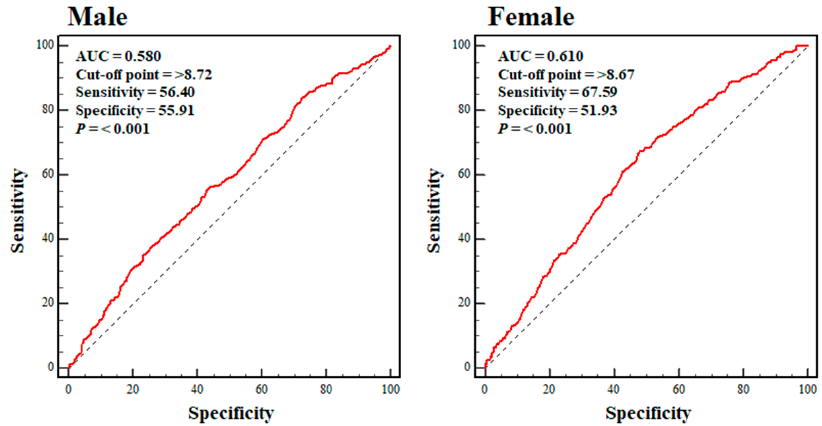
Figure 3. Sex-specific ROC curves pertaining to the TyG index for the sarcopenic obesity group. Dotted blue line: reference; solid red line: AUC, indicative of the accuracy of the use of the TyG index for the identification of sarcopenic obesity; cut-off value: the value of the TyG index that predicts sarcopenic obesity; sensitivity: the probability of individuals who actually have sarcopenic obesity being identified as having sarcopenic obesity; specificity: the probability of individuals who do not have sarcopenic obesity being identified as not having sarcopenic obesity. Abbreviations: AUC, the area under the curve; ROC, receiver operating characteristic.